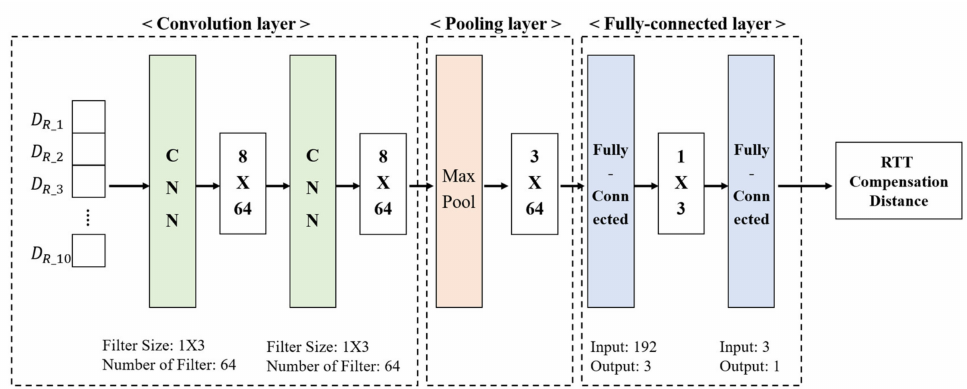
Figure 4. Proposed RTT compensation distance network